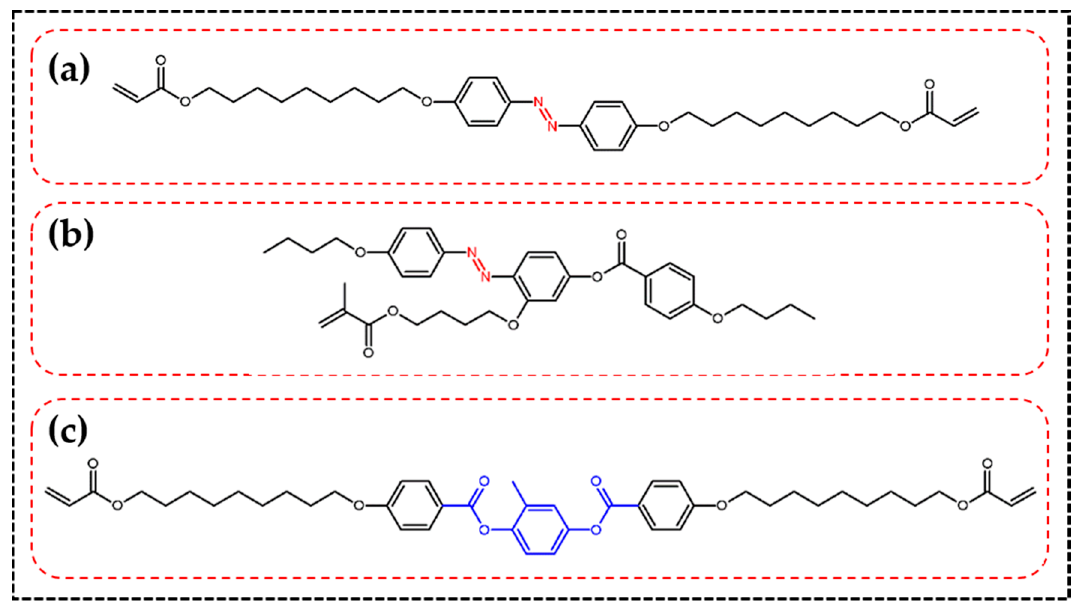
Figure 9. Chemical structures of ( a ) azo-crosslinker (c 74 °C n 91 °C i), ( b ) azo monomer (c 53 °C n 84 °C i), and ( c ) non-azo-crosslinker (c 66 °C n 92 °C i) use to construct LCE system by Braun et al. [72]. Note: c = crystalline, n = nematic, and i = isotropic.